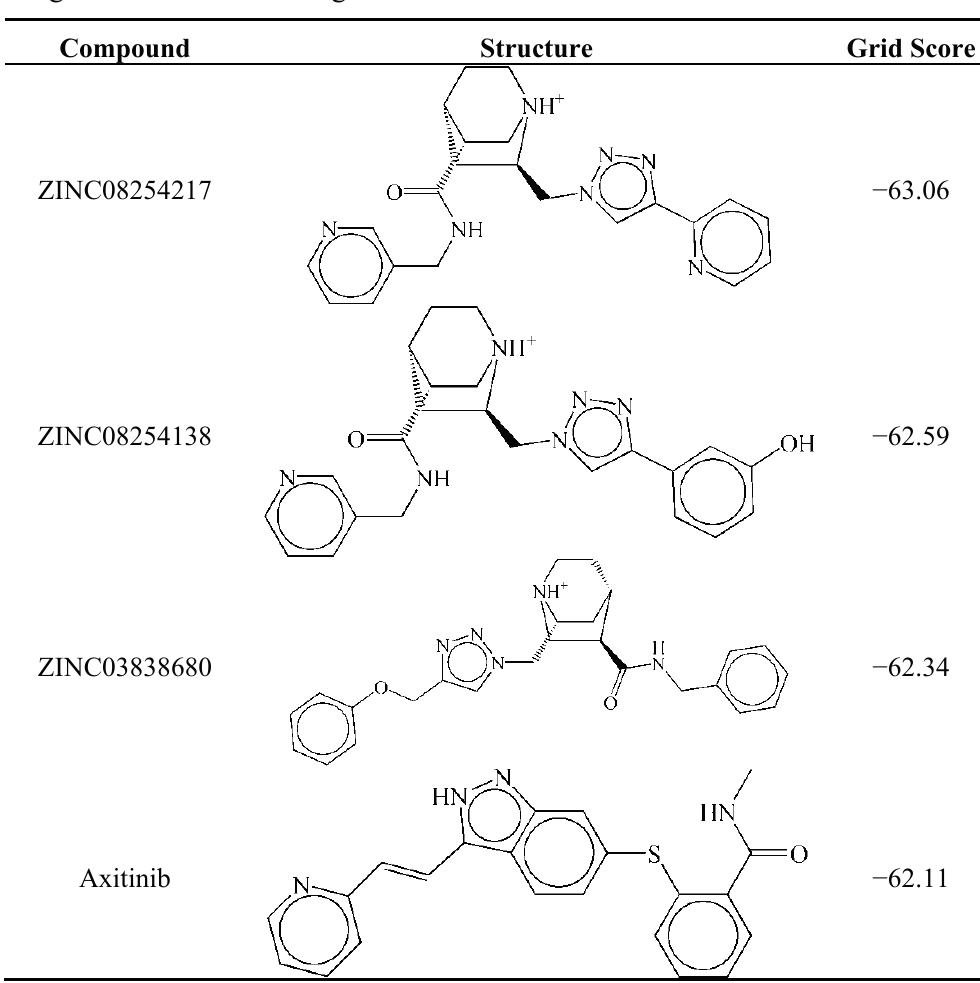
Table 1. Three candidate anti-angiogenic agents targeting VEGFR-2 result from virtual screening and molecular